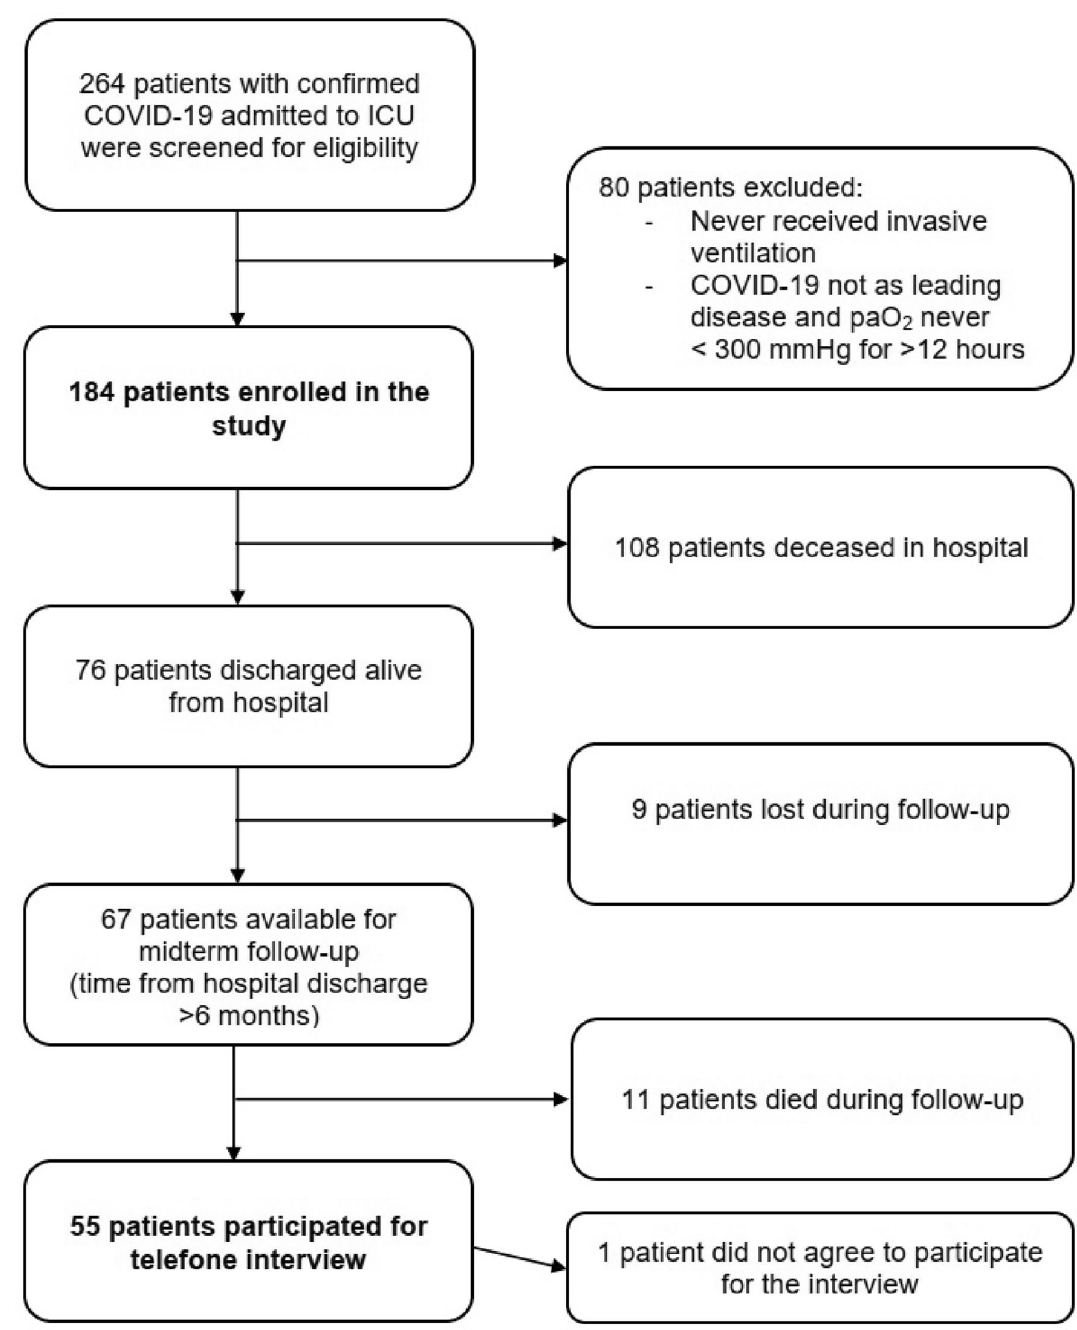
Figure 1. Flow of patient screening and enrollment. ICU intensive care unit, ARDS acute respiratory distress syndrome,